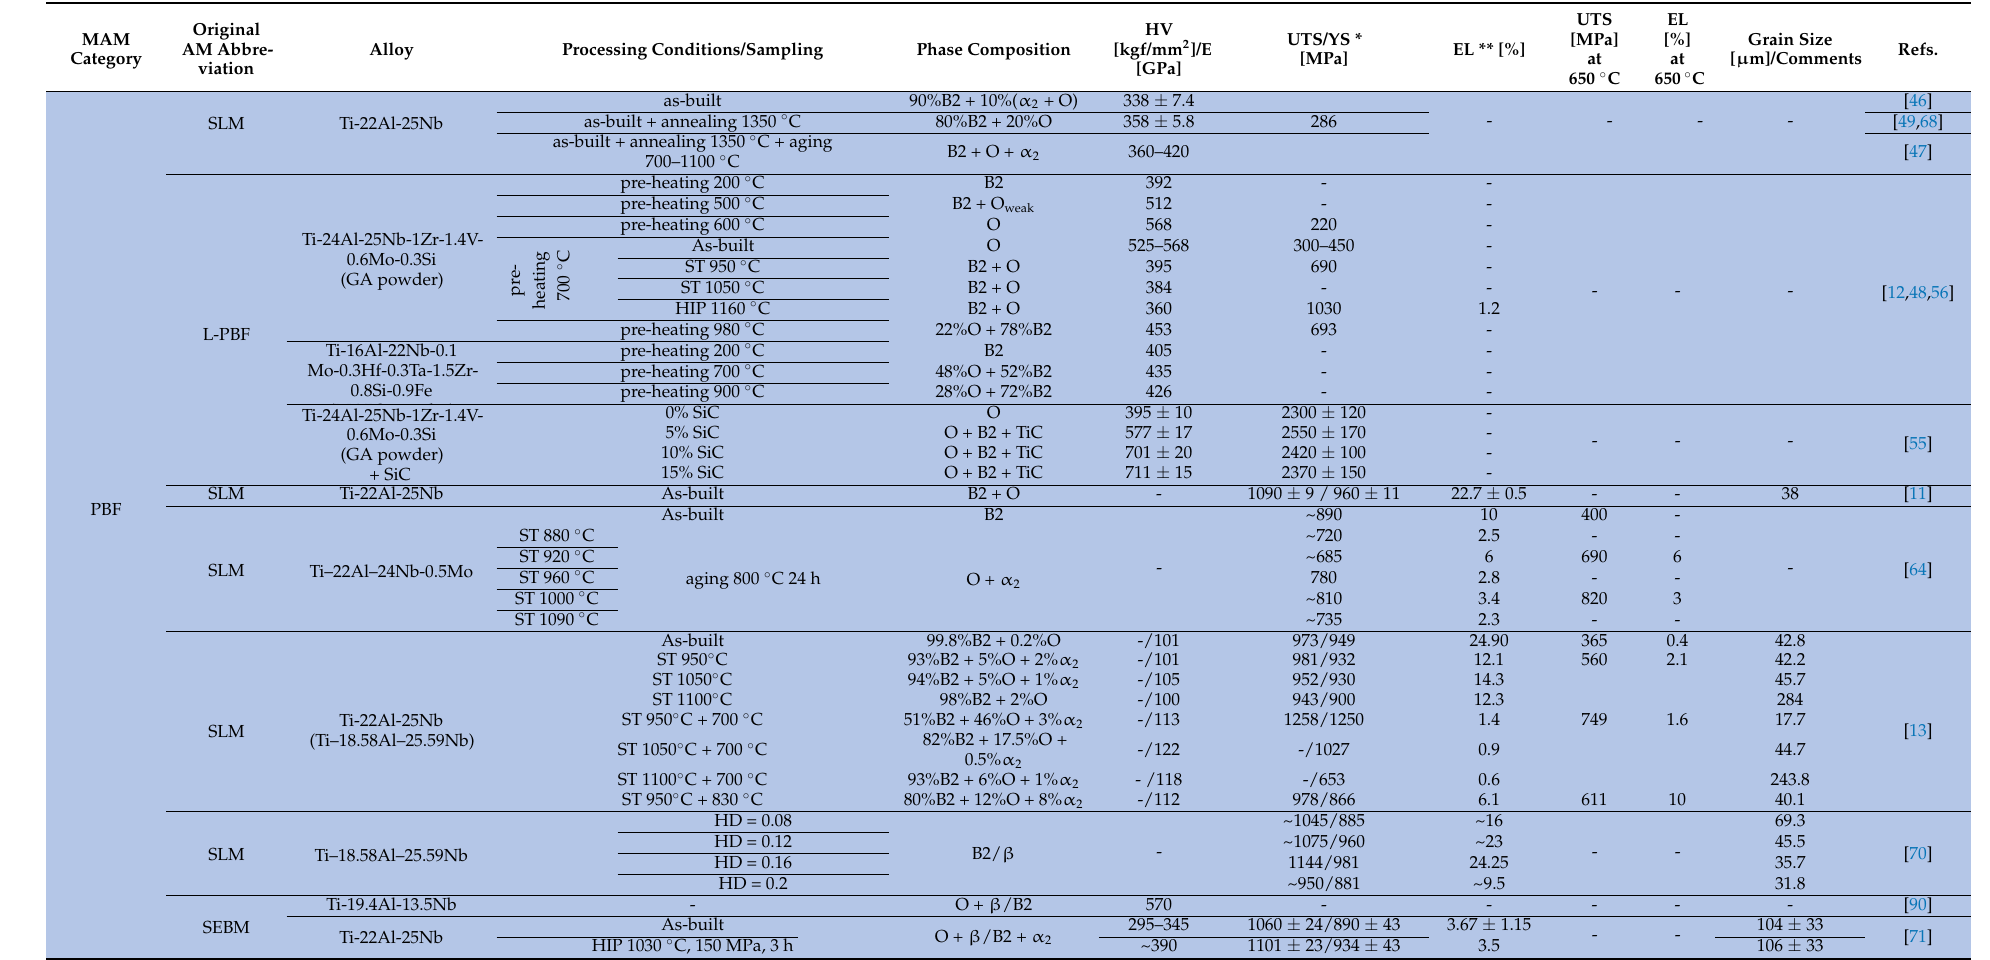
Table 6. Physical and mechanical properties of AM alloys based on orthorhombic titanium aluminides produced by